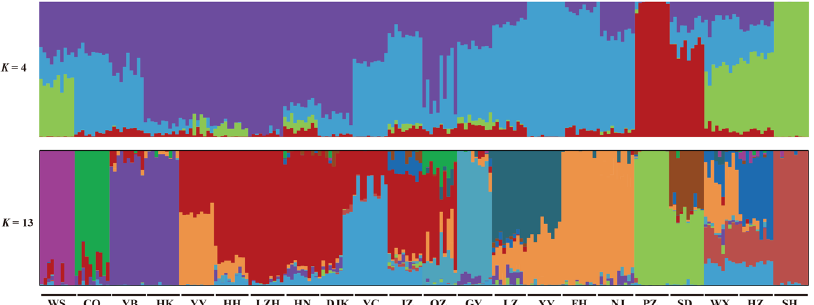
Figure 1. Population genetic structure of the 221 P. clarkii individuals. Analyses with STRUCTURE show the clustering of individuals into 4 and 13 groups. The proportion of the individual’s genome from each ancestral population is shown by the length of each colored segment.